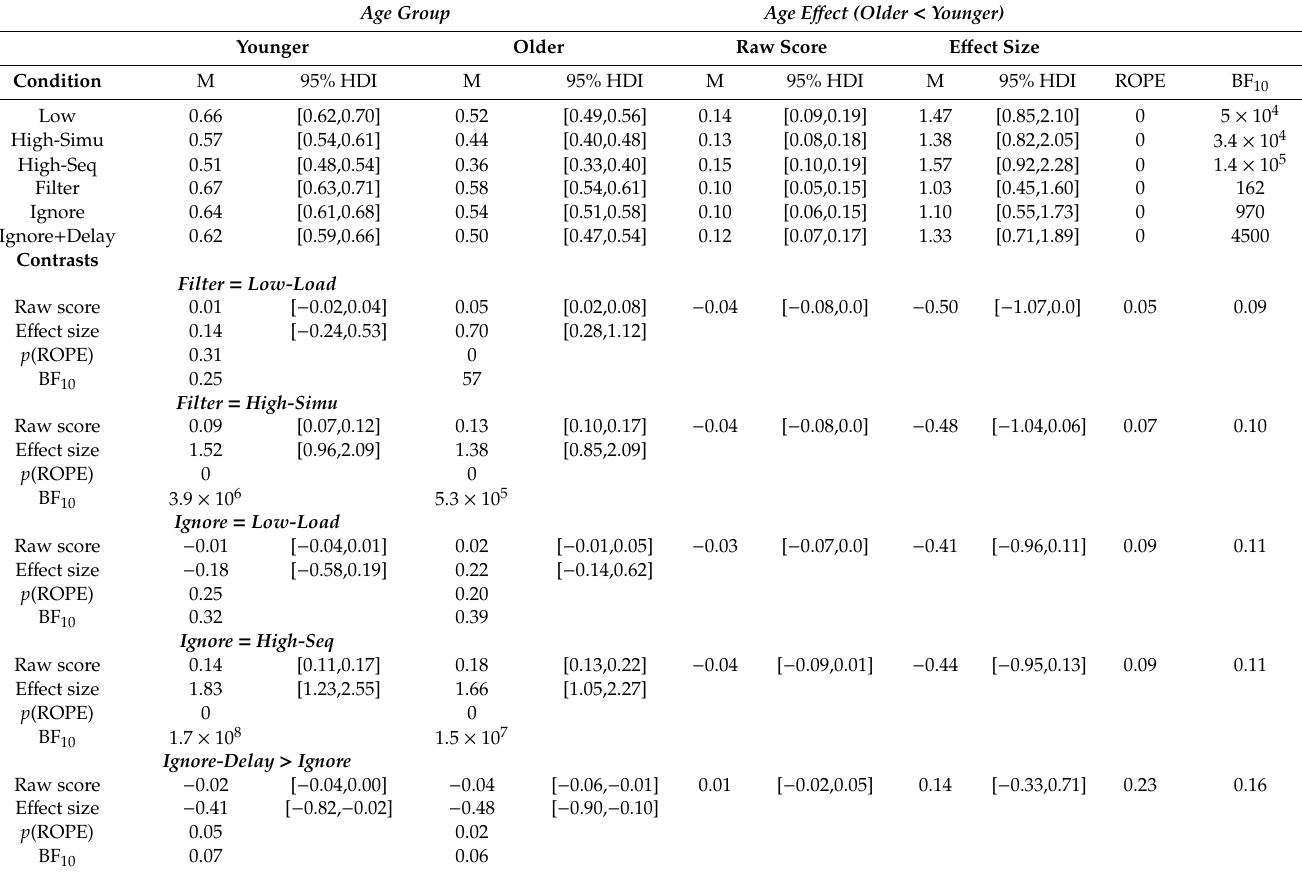
Table 1. Analysis of the data of Experiment 1. Mean recall error and 95% highest density interval (HDI) estimated from Bayesian t -tests assessing (1) the age e ff ect in each condition, (2) the filter, ignore, and delay e ff ect within each age group, and (3) the age e ff ect on the size of the filter, ignore, and delay e ff